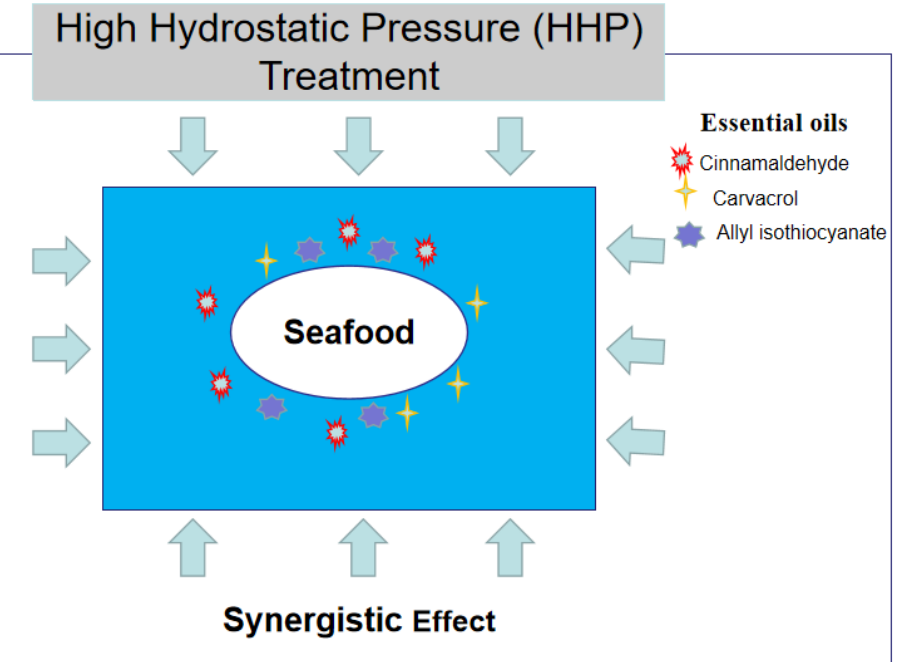
Figure 2. Combined treatment of essential oils and high hydrostatic pressure technique have synergistic inactivation effects on pathogenic and spoilage organisms in seafood.